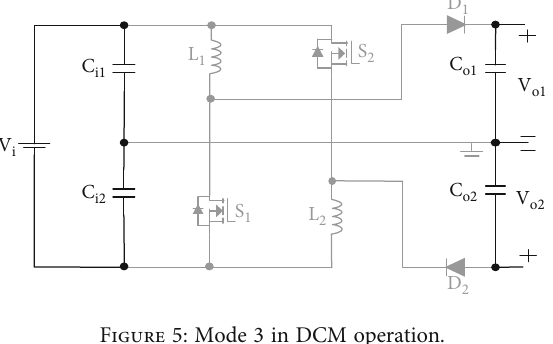
Figure 5: Mode 3 in DCM operation.